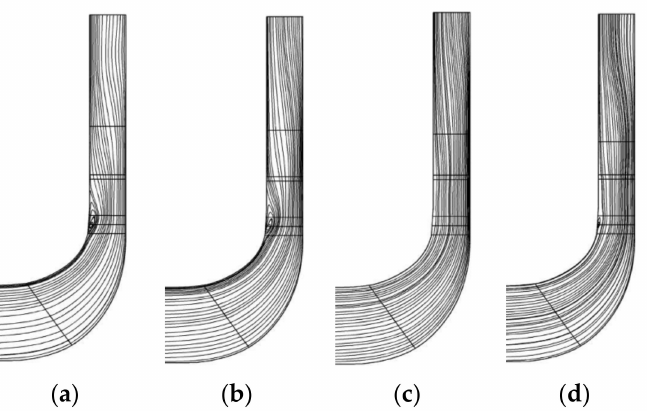
Figure 8. Variation of the total pressure loss coefficient along blade spanwise direction.